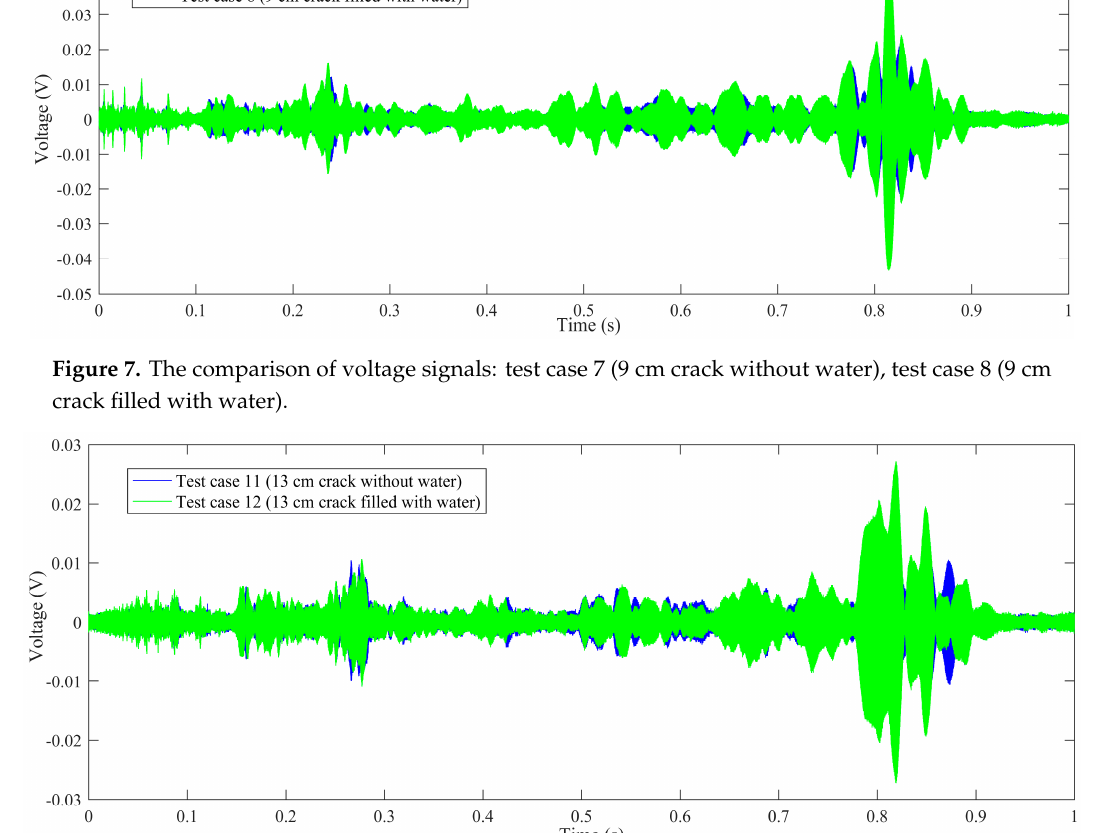
Figure 7. The comparison of voltage signals: test case 7 (9 cm crack without water), test case 8 (9 cm crack filled with water).